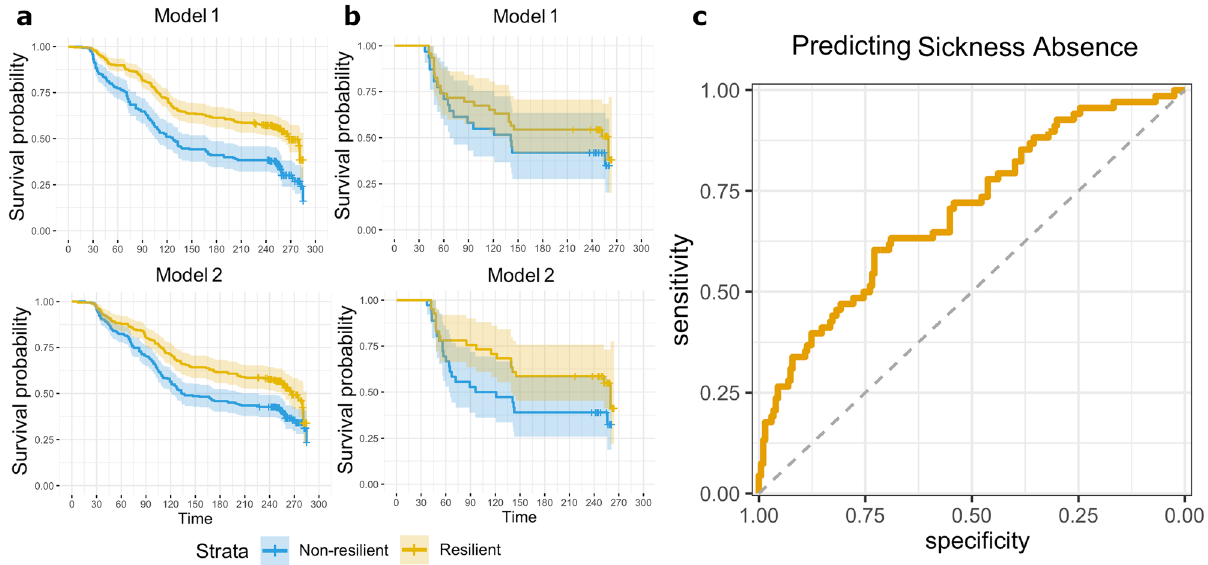
Figure 3. Relationships of the two ML models’ predictions with sickness absences over the pandemic. Survival curves for sickness absences over the follow-up using Model 1 (top) and Model 2 (bottom) in ( a ) the HUS and ( b ) the Kymsote sample in HCWs predicted as nonresilient (blue) and resilient (yellow). ( c ) Predicting individuals whose sickness absences totaled over two weeks over the pandemic (between March 2020 and September 2021) using average predictions of the two models in the City of Helsinki